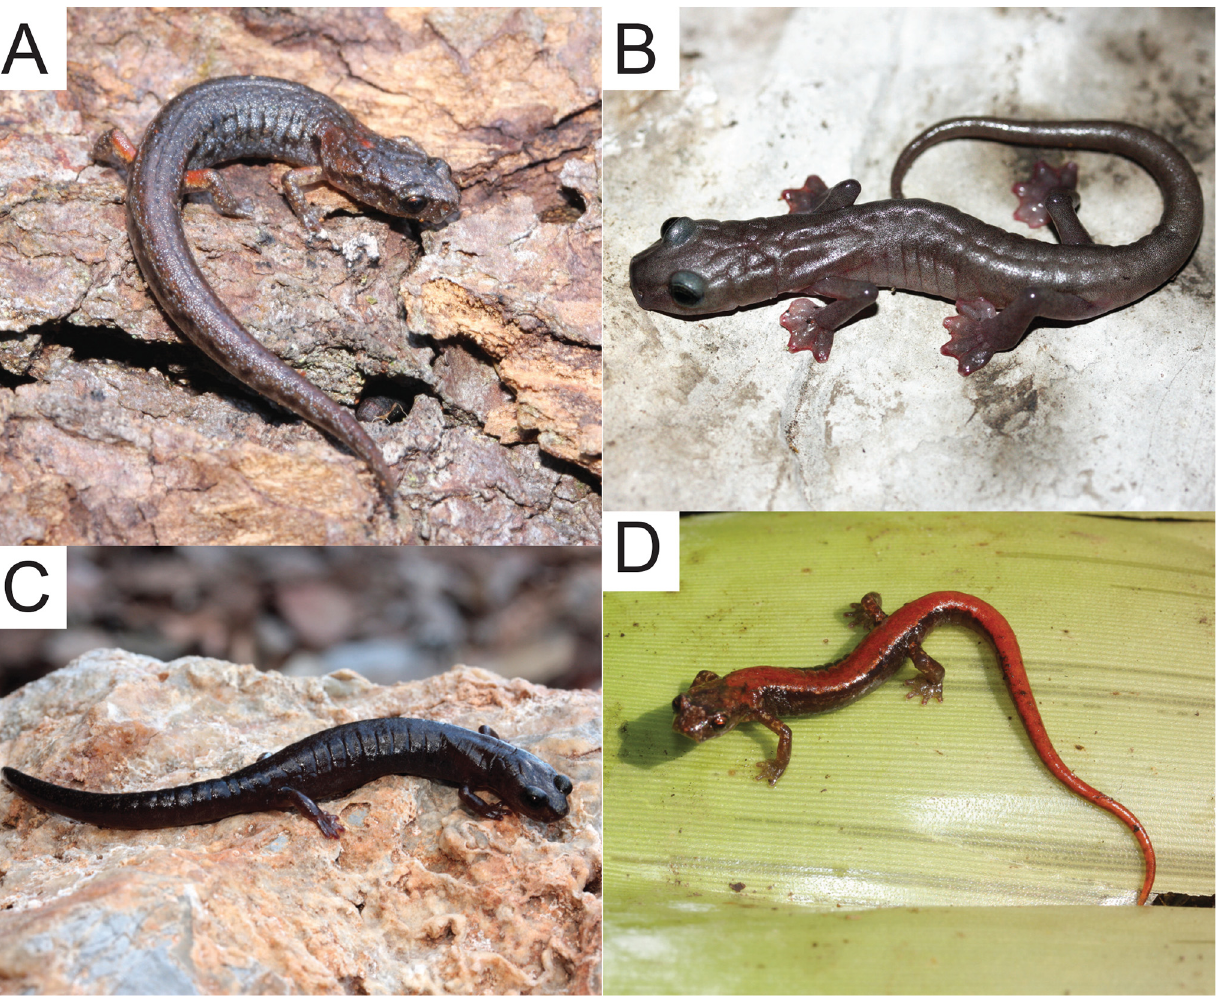
Fig 1. Photographs of the four species of Chiropterotriton examined in this study. (A) C . dimidiatus (adult SVL = approx. 25 mm); (B) C . magnipes (adult SVL = approx. 55 mm); (C) C . priscus (adult SVL = approx. 40 mm); (D) C . lavae (adult SVL = approx. 30 mm). Photos reprinted under a CC BY license, with permission from Sean